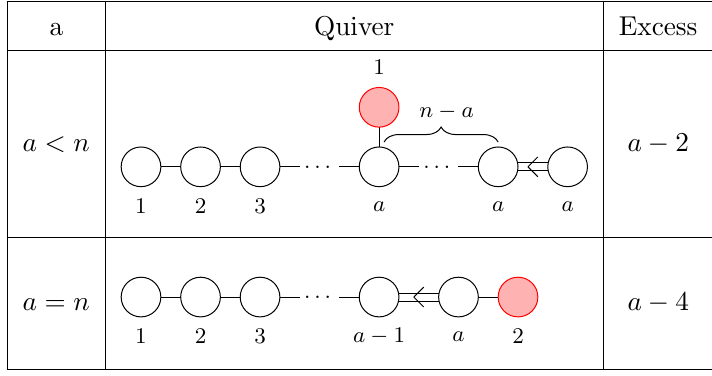
Table 9 . Classi(cid:12)cation of minimally unbalanced quivers with G = Sp( n